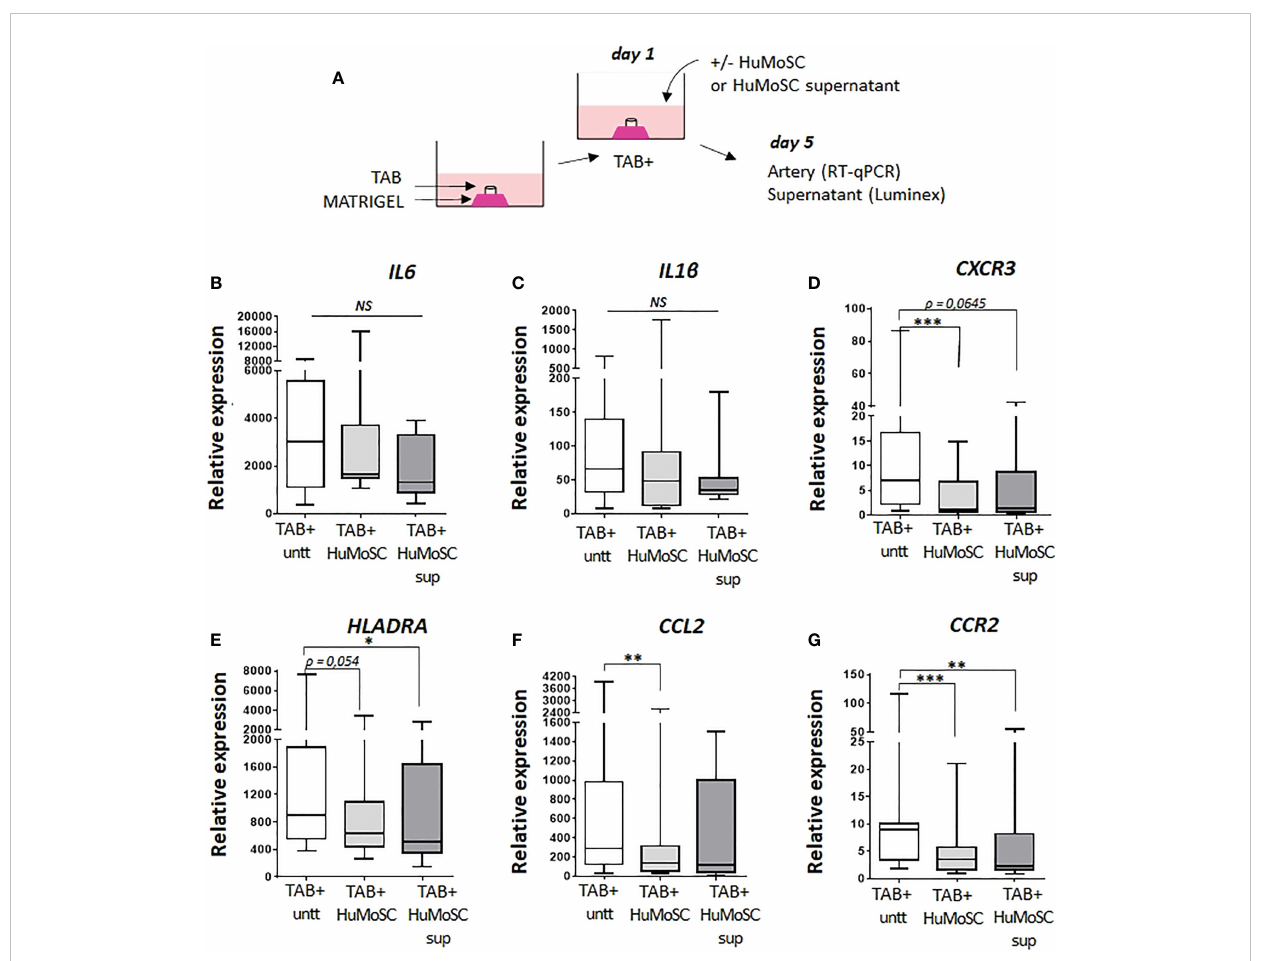
FIGURE 1 Effect of HuMoSC on vascular in fl ammation. (A) representative method for culture of temporal arteries (TABs): sections of 1 mm of fresh TABs with lesions of GCA (TAB+) were embedded in MATRIGEL. At day 1, HuMoSC (250.10 3 cells/mL) or 25% of HuMoSC supernatant was added. Each condition was performed in duplicate. After 5 days of culture, arterial sections were collected to measure mRNA by RT-PCR and the supernatant was used to measure proteins. (B-G) mRNA expression of genes implicated in vascular in fl ammation. Experimental conditions: untreated TAB+ (n=12), TAB+ treated with HuMoSC (n=11) or of HuMoSC supernatant (n=10). Whisker boxes show the median (horizontal bar), the IQR (limits of the box) and extreme values (error bars). P is the result of Wilcoxon tests. Signi fi cant results are shown ( *P < 0.05, **P < 0.01 and ***P < 0.001 , NS, Not Signi fi cant) otherwise non-signi fi